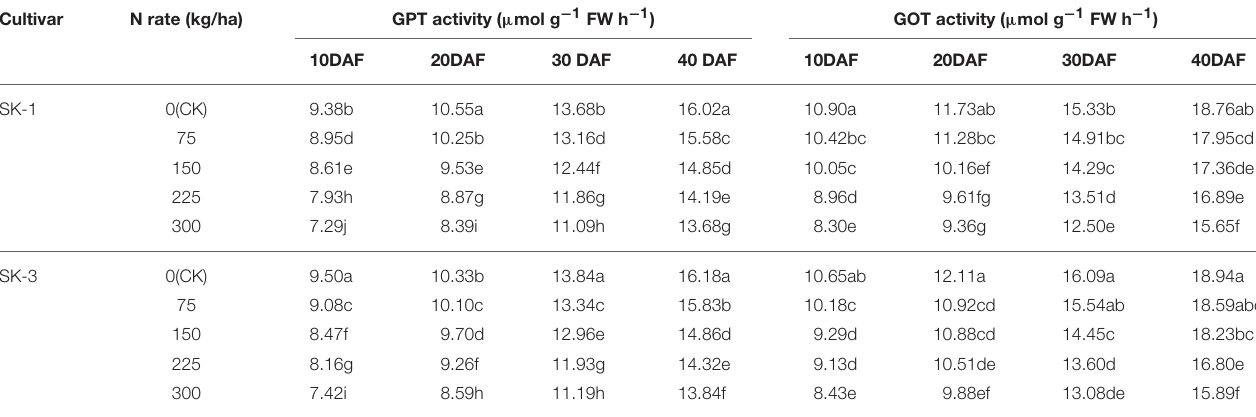
TABLE 8 | The effect of the nitrogen level on the boll shell glutamic-pyruvic transaminase (GPT) and glutamic-oxalacetic transaminase (GOT) activities of the two Bt cotton cultivars in 2016.